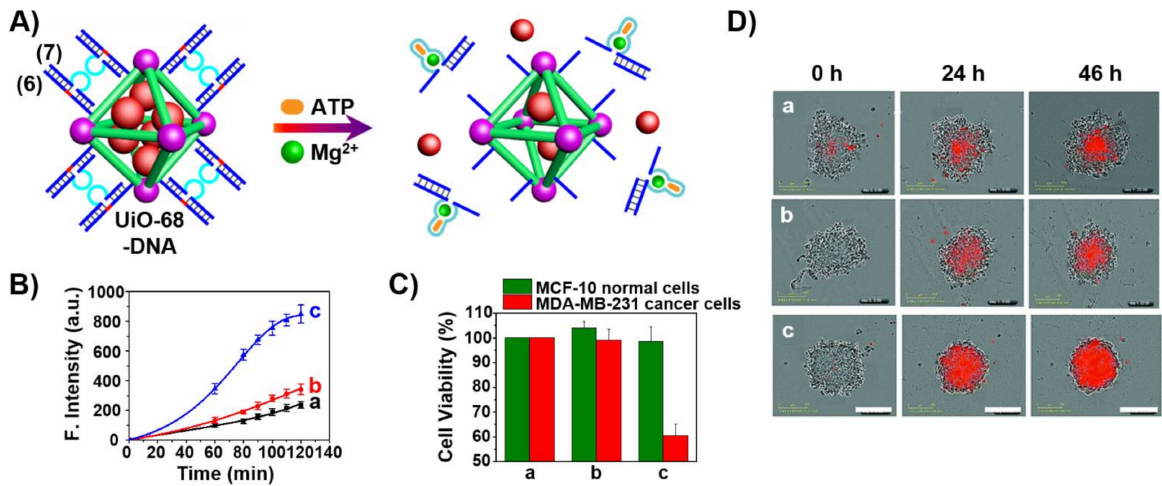
Figure 8. ( A ) DOX-loaded UiO-68 NMOFs gated by the strands ( 6 )/( 7 ), and their cooperative unlocking in the presence of Mg 2+ and ATP. Strand (6) contains the ribonucleobase corresponding to substrate of the Mg 2+ -dependent DNAzyme and strand ( 7 ) includes the Mg 2+ dependent DNAzyme sequence integrated with the ATP aptamer sequence. ( B ) Time- dependent release of DOX from the ( 6 )/( 7 )-locked DOX-loaded UiO-68 NMOFs: (a) in the absence of the Mg 2+ -ions and ATP. (b) only in the presence of Mg 2+ -ions, 2 mM. (c) in the presence of Mg 2+ -ions, 2 mM and ATP, 3 mM. ( C ) Cytotoxicity of the ( 6 )/( 7 )-locked DOX-loaded NMOFs towards MCF-10A normal epithelial breast cells (green) and MDA-MB-231 breast cancer cells (red): a = untreated cells, b = ( 6 )/( 7 )-locked, unloaded NMOFs, c = ( 6 )/( 7 )-locked, DOX-loaded NMOFs. ( D ) Typical apoptosis color images after 0, 24 and 46 h corresponding to = a. untreated cell aggregates; b = cell aggregates treated with ( 6 )/( 7 )-locked, unloaded NMOFs; c = cell aggregates treated with ( 6 )/( 7 )-locked, DOX-loaded NMOFs. Reproduced with permission from ref. [145]. Copyright 2017 Royal Society of